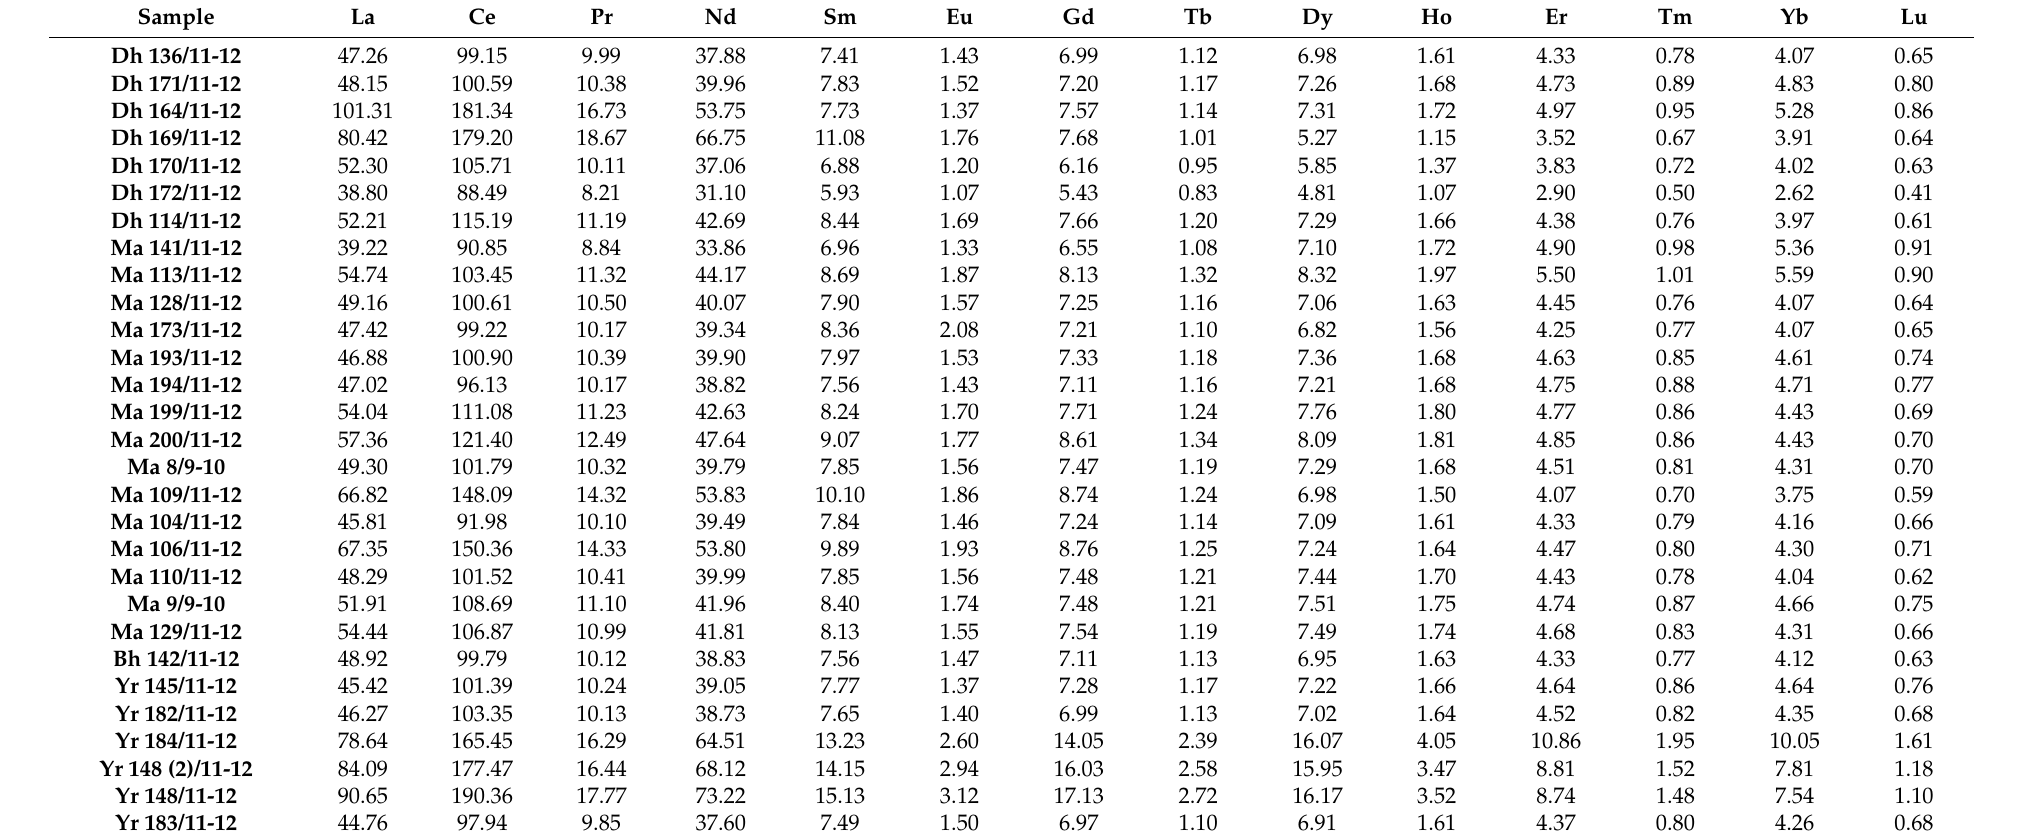
Table 6. Concentration of rare earth elements (ppm) in the Mesozoic mudstone